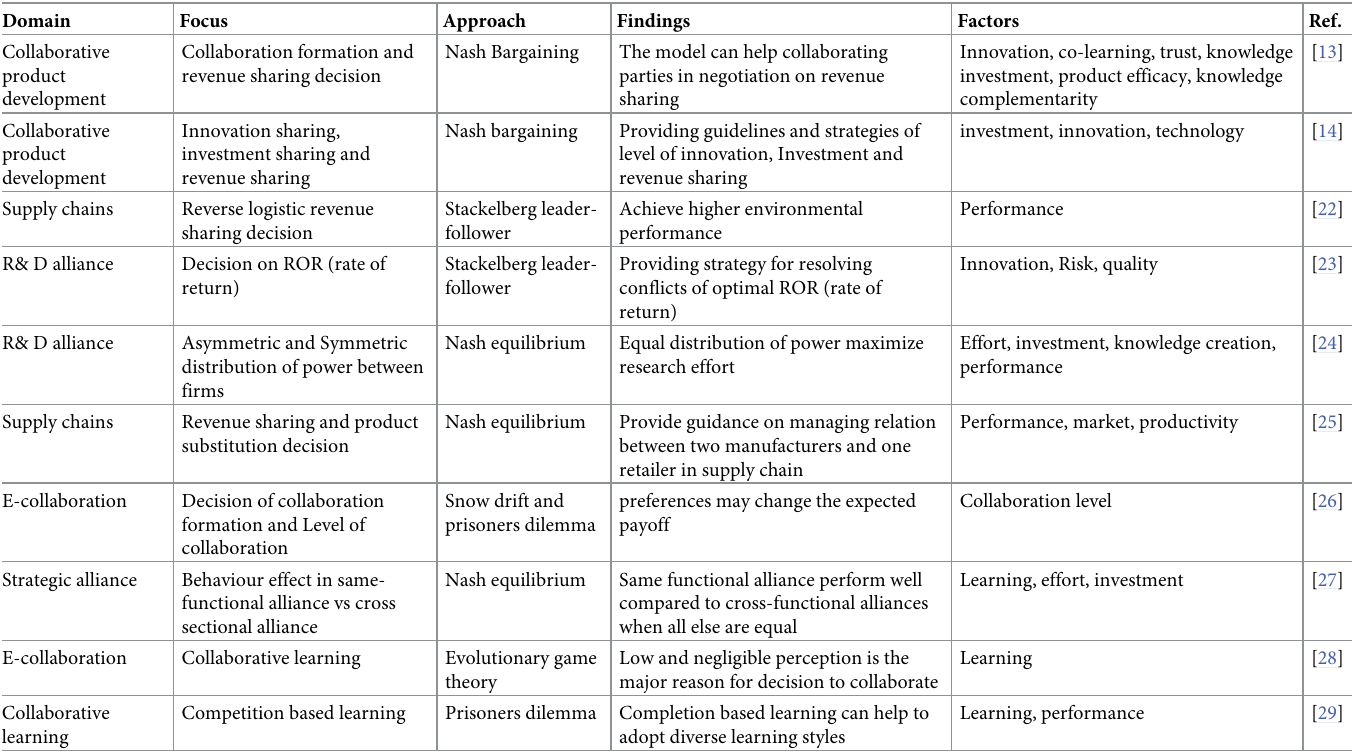
Table 2. Game theory literature on